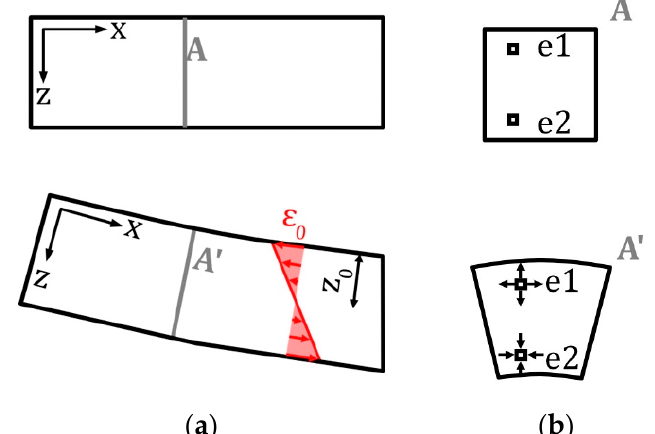
Figure 9. Analytical analysis of a composite bending beam. Without load shown on the top and with load on the bottom ( a ). Stress distribution caused by the constant moment is visualized in red. ( b ) Sections of the bending beam showing two elements (e1 and e2) and their deformation. The hypothesis is based on the mechanical interaction of the GFRP structure with the ITFC. On the tension side, the energy storage will mostly see tension in a